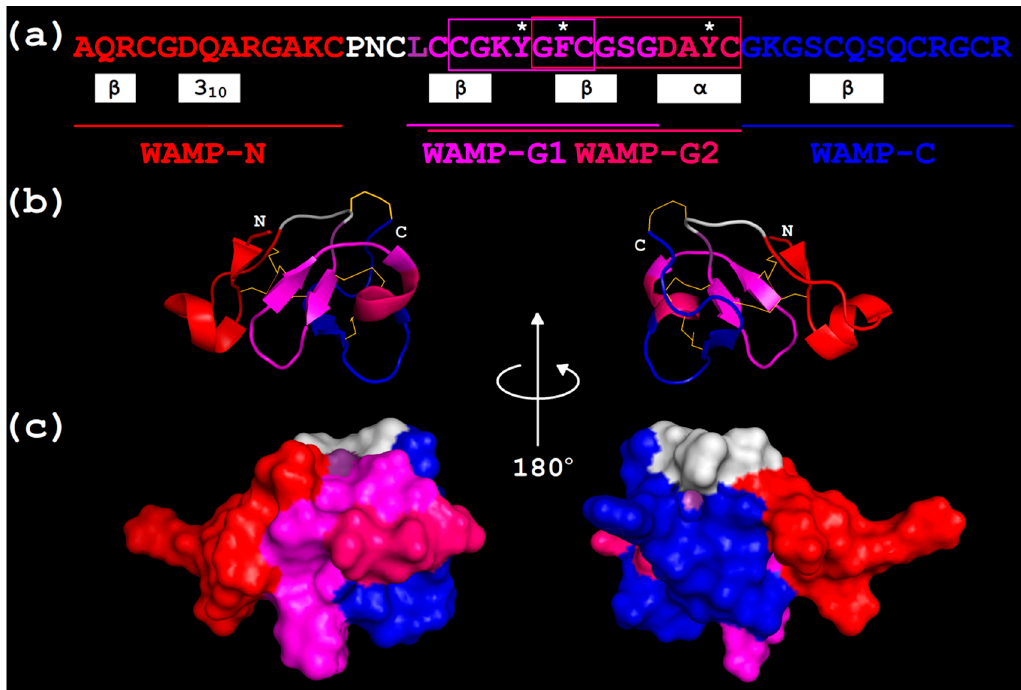
Figure 3. WAMP-2-derived peptides. The position of WAMP-N, WAMP-G1, WAMP-G2, and WAMP-C colored red, magenta, pink and blue, respectively, in the WAMP-2 sequence, and the 3D structure is indicated. ( a ) WAMP-2 amino acid sequence [17]. Secondary structure elements (helices and beta-strands) are shown as white rectangles below the sequence [16]. The conserved aromatic residues of the chitin-binding site are marked with asterisks. The gamma-core regions are framed. ( b ) Superimposition of WAMP-2-derived peptides on the spatial structure of WAMP-1a (PDB 2LB7) (ribbon representation). Beta-strands are shown as arrows and 3 10 and alpha-helices, as ribbons. The N-and C-termini are indicated by N and C, respectively. Disulphide bridges are shown by thin yellow lines. ( c ) Superimposition of WAMP-2-derived peptides on the surface structure of WAMP-1a.